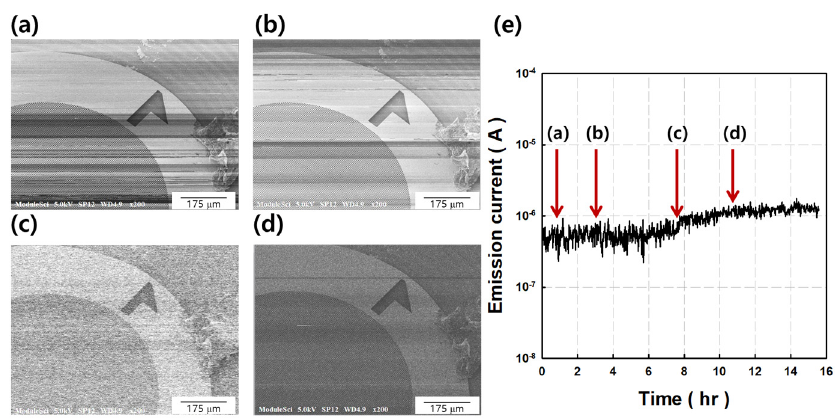
Figure 5. Scanning secondary electron image with CNT cold cathode gun. ( a – d ) SEM images of Cu grid mesh (2000) during aging process. ( e ) Electron emission current stability in constant voltage mode ( ∆ V = 900 V) ( ∆ V = V acc − V ex